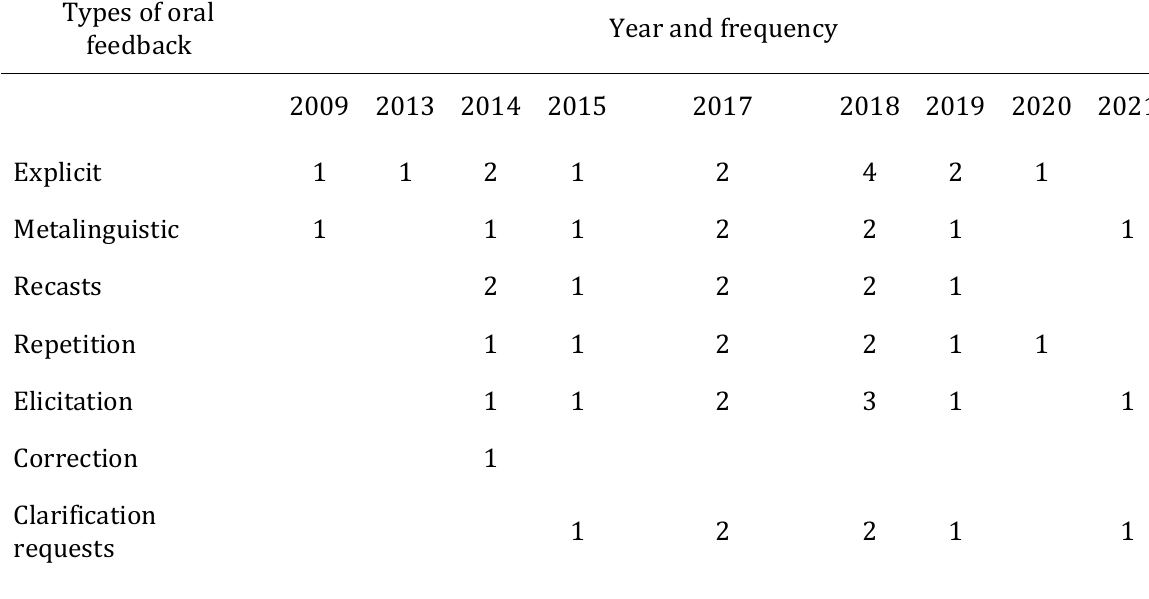
Table 1. Types of Oral